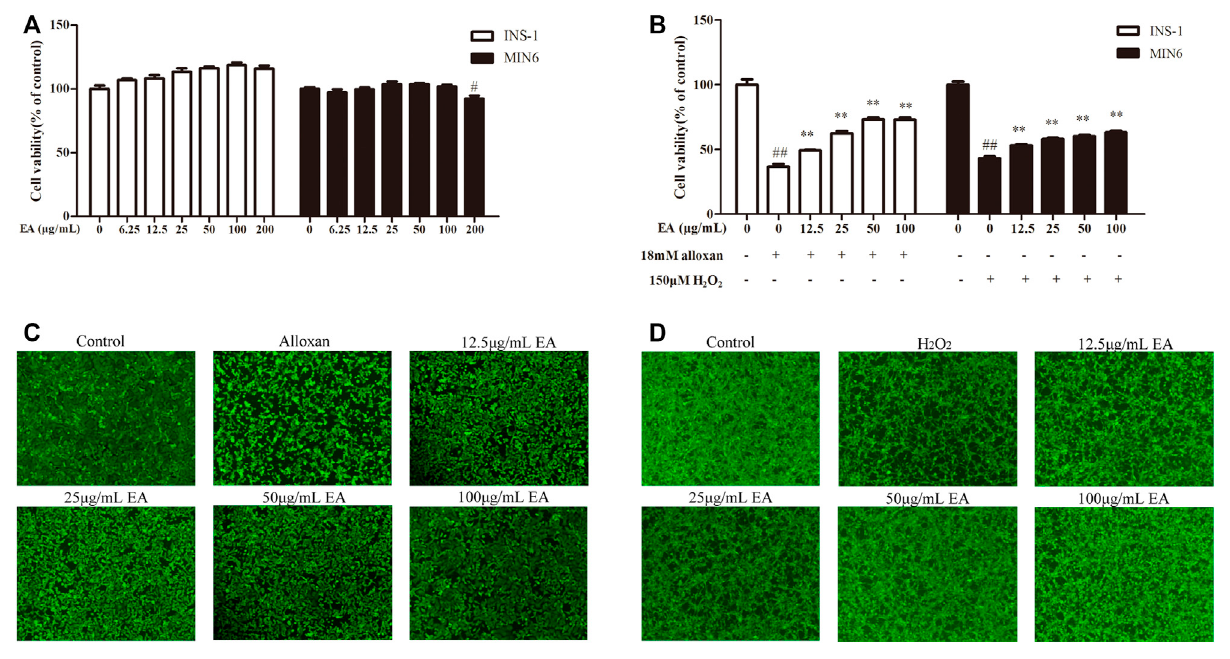
FIGURE 1 Cytotoxicity and cytoprotective effects of EA in β cell lines. INS-1 cells and MIN6 cells were exposed to EA (0 – 200 μ g/mL) for 24 h (A) , INS-1 cells wereco-treated withtheindicated concentrations ofEAandalloxan(18 mM),orMIN6cells wereco-treatedwith theindicatedconcentrationsofEAand H 2 O 2 (150 μ M) for 24 h, respectively (B) , and then the cell viability was determined by the CCK-8 assay. (C,D) Morphologic observation of INS-1 cells and MIN6cellstreatedasindicatedandstainedwithcalcein-AM.Representativeimageswereacquiredbya fl uorescencemicroscope.Treatmentofcells withEAmarkedlyimprovedthemorphologicchangesofINS-1cellscausedbyalloxanandinMIN6cellscausedbyH 2 O 2 .Dataarethemean±SEM(n=3). # p < 0.05 compared with control, ## p < 0.01 compared with control, * p < 0.05 compared with the OS-model group, ** p < 0.01 compared with the OS- model